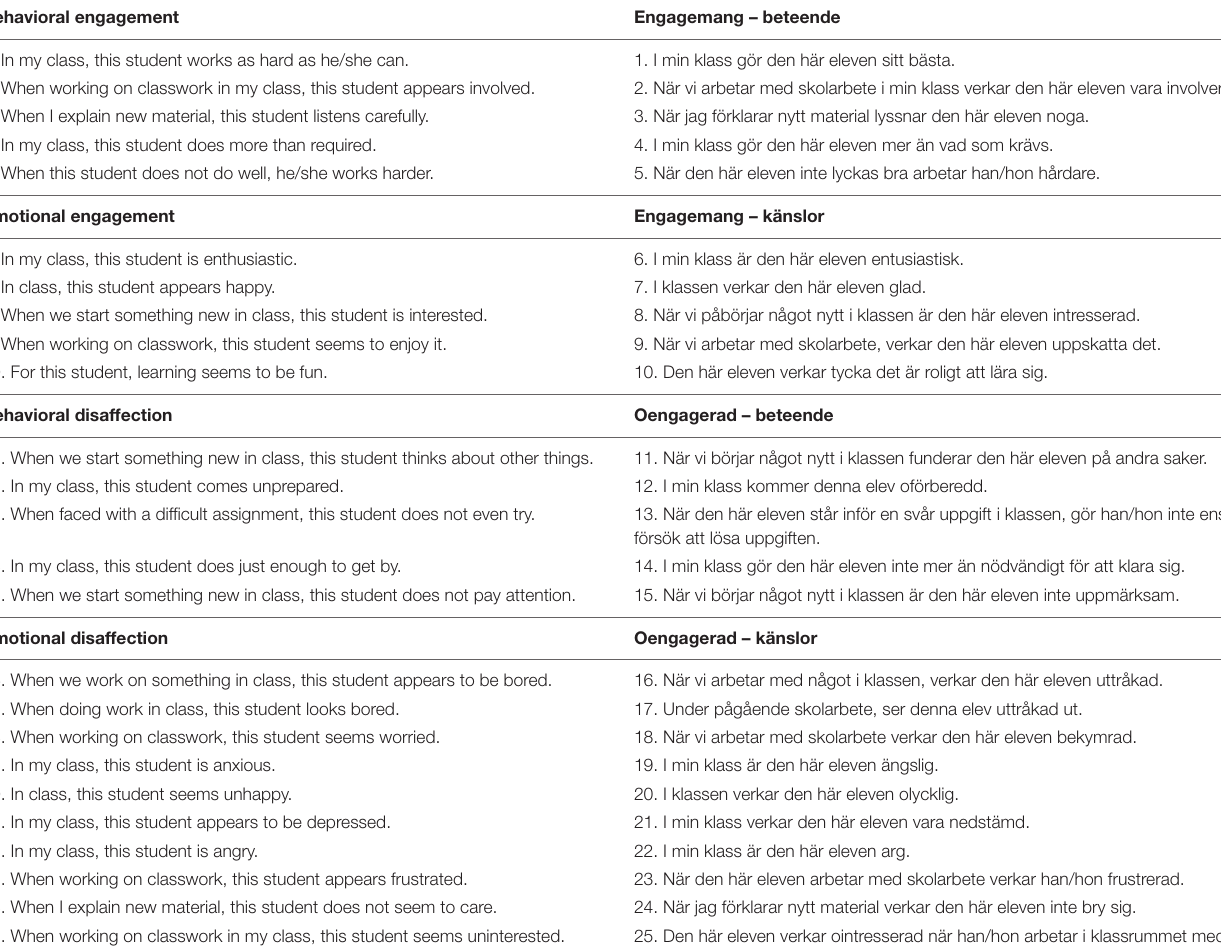
TABLE A1 | Questionnaire items in English (Skinner et al., 2009b) (left column) and their translation to Swedish (right column). Behavioral engagement Engagemang –